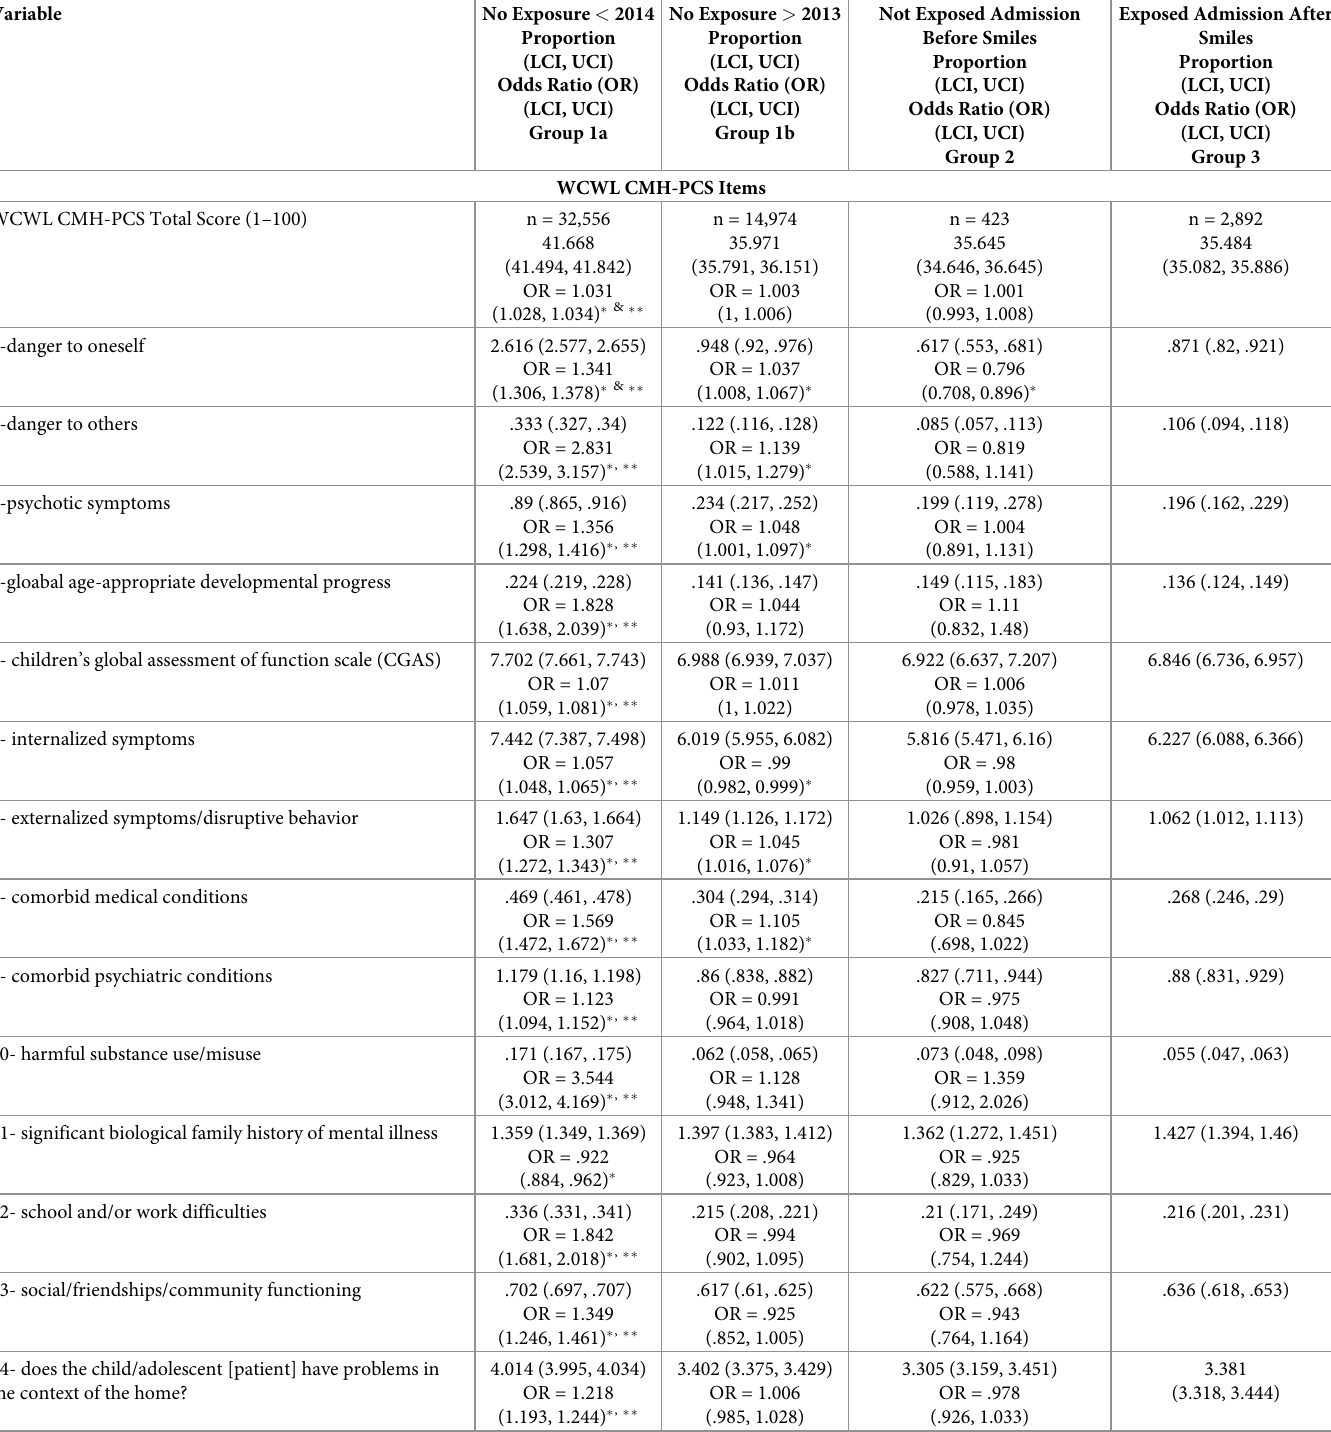
Table 1. Description of independent variables by dependent groups and bivariate multinomial logistic regression of independent variables by dependent groups. All individual WCWL CMH-PCS Item data calculated based on the same number of participants in the total score calculation and therefore were not included in the indi- vidual